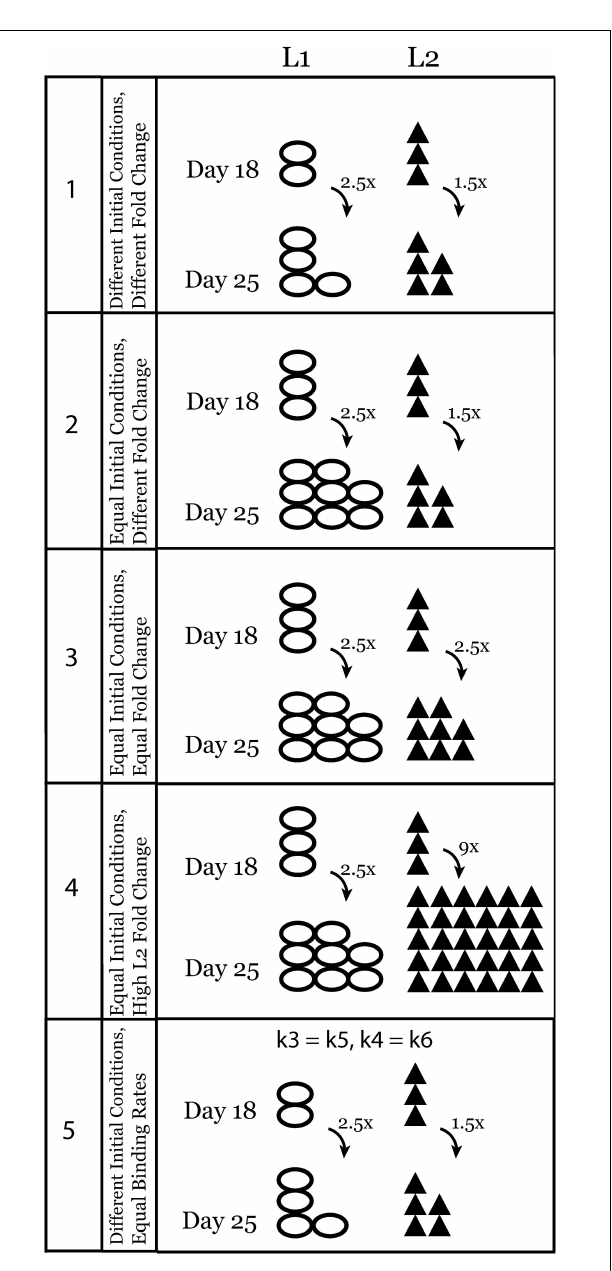
FIGURE 2 | Schematic representation of experimental conditions that were tested using the ODE model of ligand competition. Conditions are numbered from 1 to 5 and this numbering is also used in the figures and